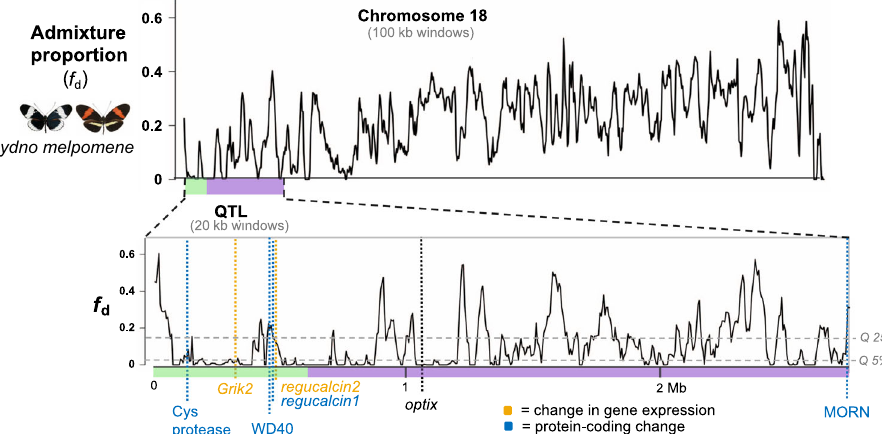
Fig. 4 Gene fl ow at the QTL region for behaviour. Admixture proportion ( f d ) values estimated in overlapping 100 kb (top) and 20 kb (bottom) windows for chromosome 18 (top) and the QTL region (bottom) between H. melpomene rosin a and H. cydno chioneus , with candidate genes positions highlighted by a vertical dashed line, and optix location displayed for reference. The x -axis represents physical position, the y -axis indicates the f d value. f d values close to zero indicate that the proportion of shared derived alleles, and consequently gene fl ow, between H. melpomene and H. cydno is small (or zero), implying localized selection against foreign alleles that introgress between the two species. 5 and 25% quantile of the f d distribution are indicated by horizontal grey dotted